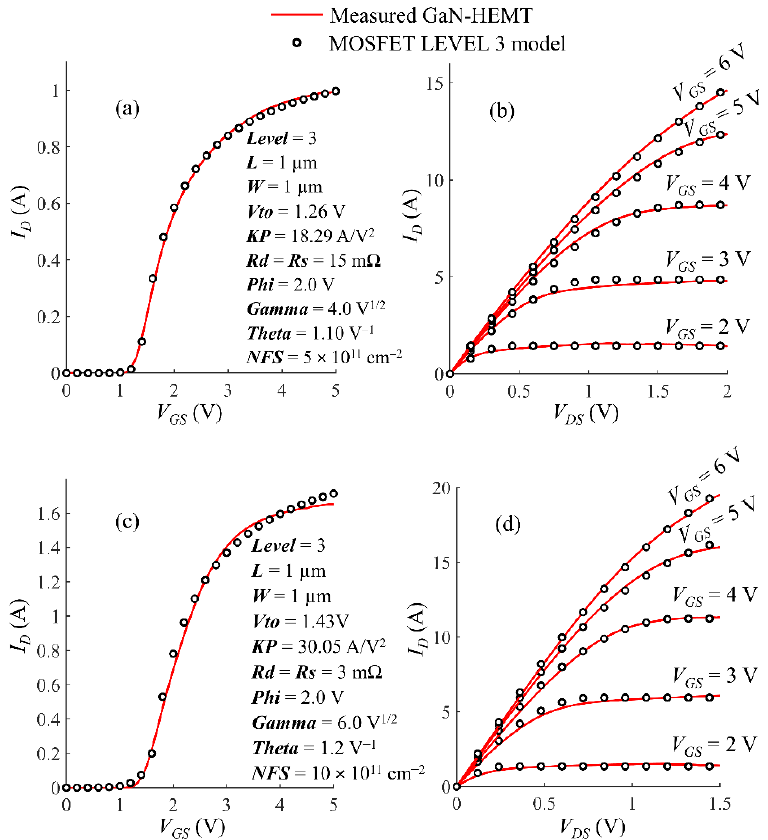
Figure 4. Verification of MOSFET LEVEL 3 model for GS66504B using measured ( a ) transfer characteristics and ( b ) output characteristics. Verification of MOSFET LEVEL 3 model for GS66506T using measured ( c ) transfer characteristics and ( d ) output characteristics.